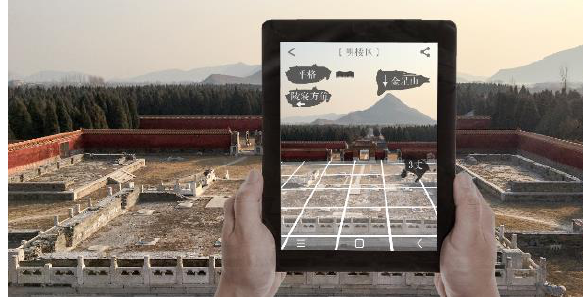
Figure 49. The plain grid technique on the screen